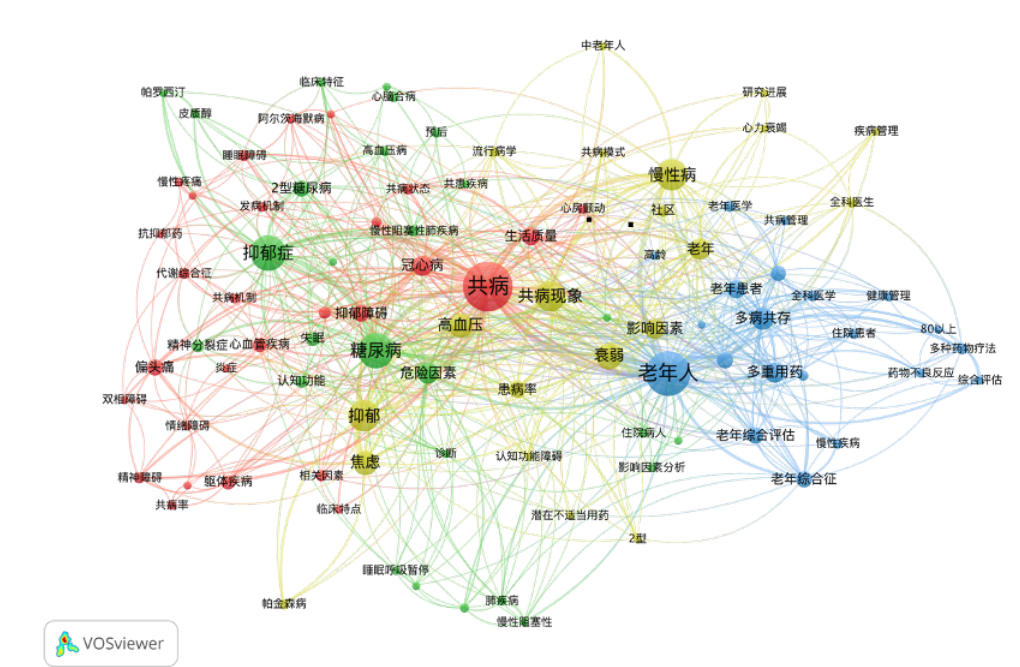
Figure 9. Co-keywords analysis of Chinese high-frequency. Table 6. Cluster keywords analysis of Chinese articles. Table 4. Cluster keywords analysis of English articles.